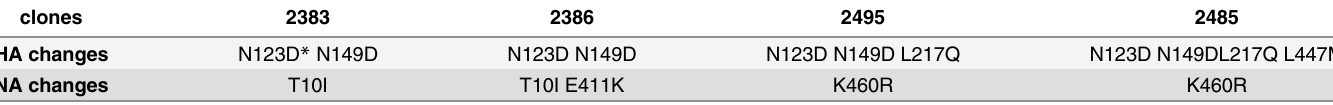
Table 1. Amino acid changes in HA and NA sequences of reassortants during generation of A/Anhui/01/2013-CDC-LV7A.